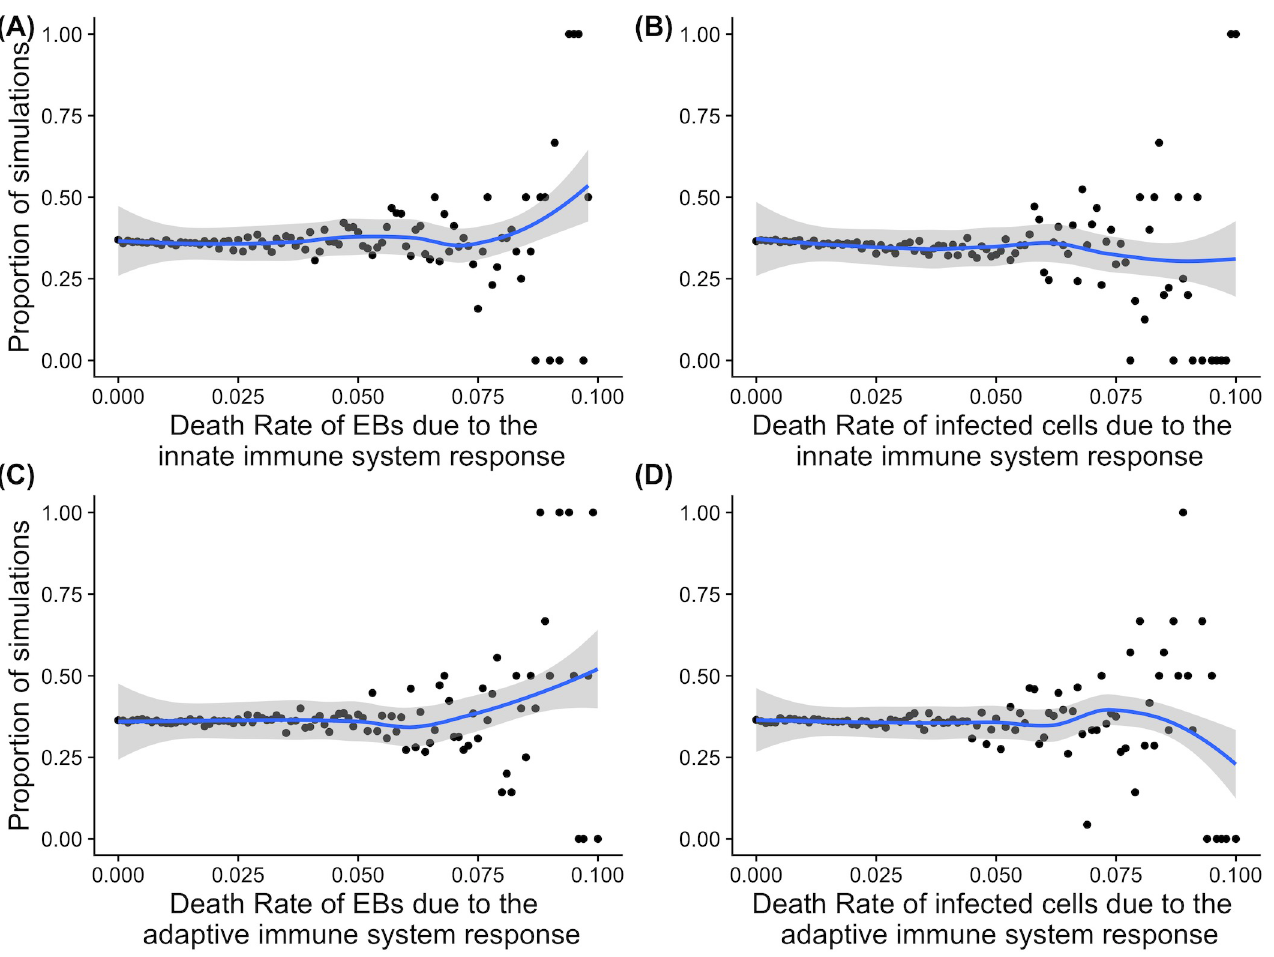
Fig 7. Graphical representation of the impact of the immune response and subsequent chlamydial death rate on the proportion of simulations that result in ascension. The proportion of simulations where the infection ascends was computed (total 252,500 simulations represented in each figure). Each figure shows the proportion of simulations where the infection ascended on the y axis and on the x axis the death rate of EBs and infected cells due to different components of the immune system (represented as broad scales of response). (A) Impact of EB death rate due to the innate immune system on the proportion ascending, (B) Impact of infected cells death rate due to the innate immune system on the proportion ascending, (C) Impact of EB death rate due to the adaptive immune system on the proportion ascending, and (D) Impact of infected cells death rate due to the adaptive immune system on the proportion ascending. These are simulated over a range of infectious loads (10 simulations at each value of infectious load from 1 to 10001 in steps of 100.The solid blue line indicates a loess fit to the proportion of simulations the ascended and the shaded area represents 95% Confidence Intervals of the loess regression. Dots represent simulations at a particular parameter value from a total of 252,